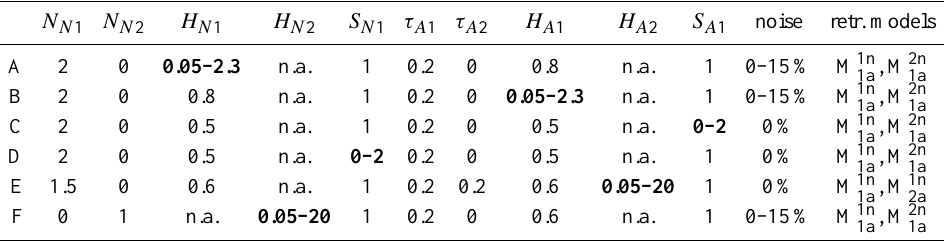
Table 2. Overview of the variable settings in the sensitivity studies. In each sensitivity study, the retrieval is tested for different values of the variable of which the range is indicated in boldface. Measurements are simulated for the settings given by the table, and analyzed with the retrieval models given in the final column. Note that the variables S N 1 , S A 1 , H N 2 , and H A 2 , have fixed values in the retrieval models, but are varied in the simulation of measurements for this sensitivity study. All partial NO 2 columns ( N N 1 and N N 2 ) are given in 10 16 moleccm − 2 and all heights are given in km.